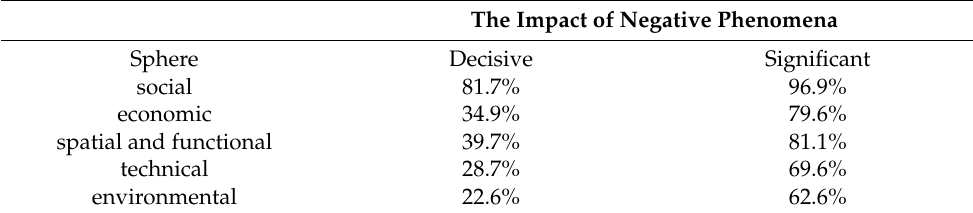
Table 2. The impact of individual spheres on the designation of degraded